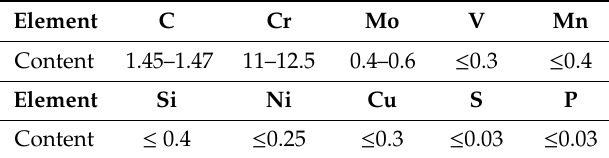
Table 1. Chemical composition of Cr12MoV hardened steel [31].